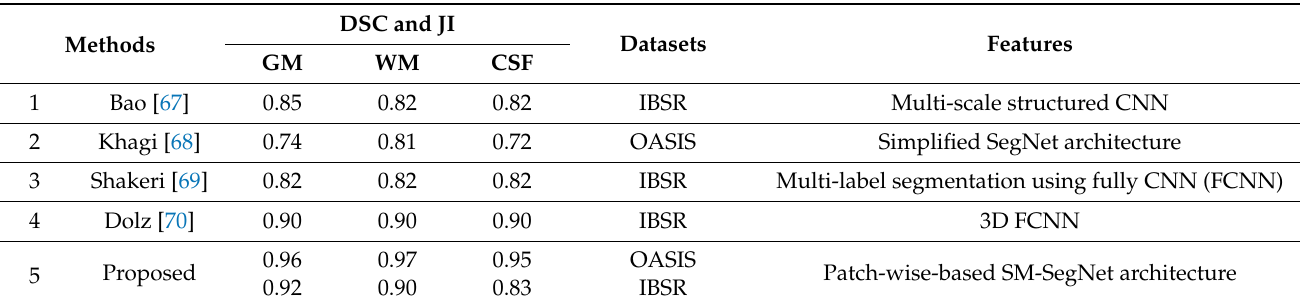
Table 6. DSC and JI scores achieved by the proposed method in comparison with the state-of-the-art methods based on the publicly available database.